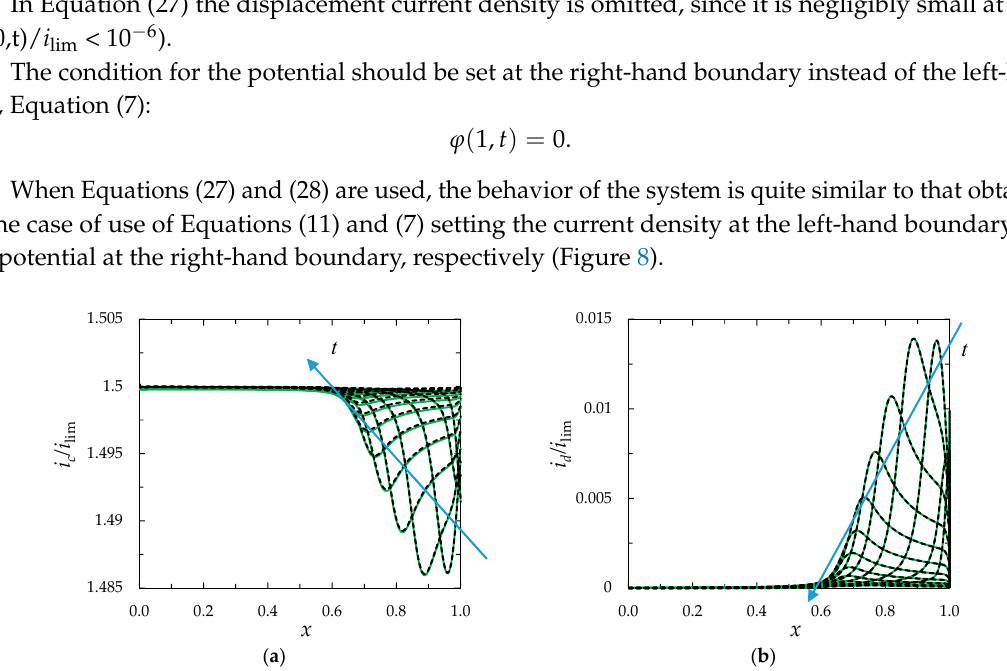
Figure 8. Distribution of conduction current density, i c / i lim , ( a ) and displacement current density, i d / i lim , ( b ), computed at different times, t , in the case of ε = 3 × 10 − 5 , i/i lim = 1.5, T 1 = 0.972, N c = 1. The solid lines relate to the case where the current density is set at the right-hand boundary, Equations (7) and (11); the dotted lines, to the case of left-hand boundary, Equations (27) and (28); t = 0.1, 0.2, …, 1.5. Comparison of the i c ( x , t ) functions computed using the “primary”, “zonal” and “simplified” models shows a very good agreement between all three models, (the values differ by less than 0.03%), Figure 9.